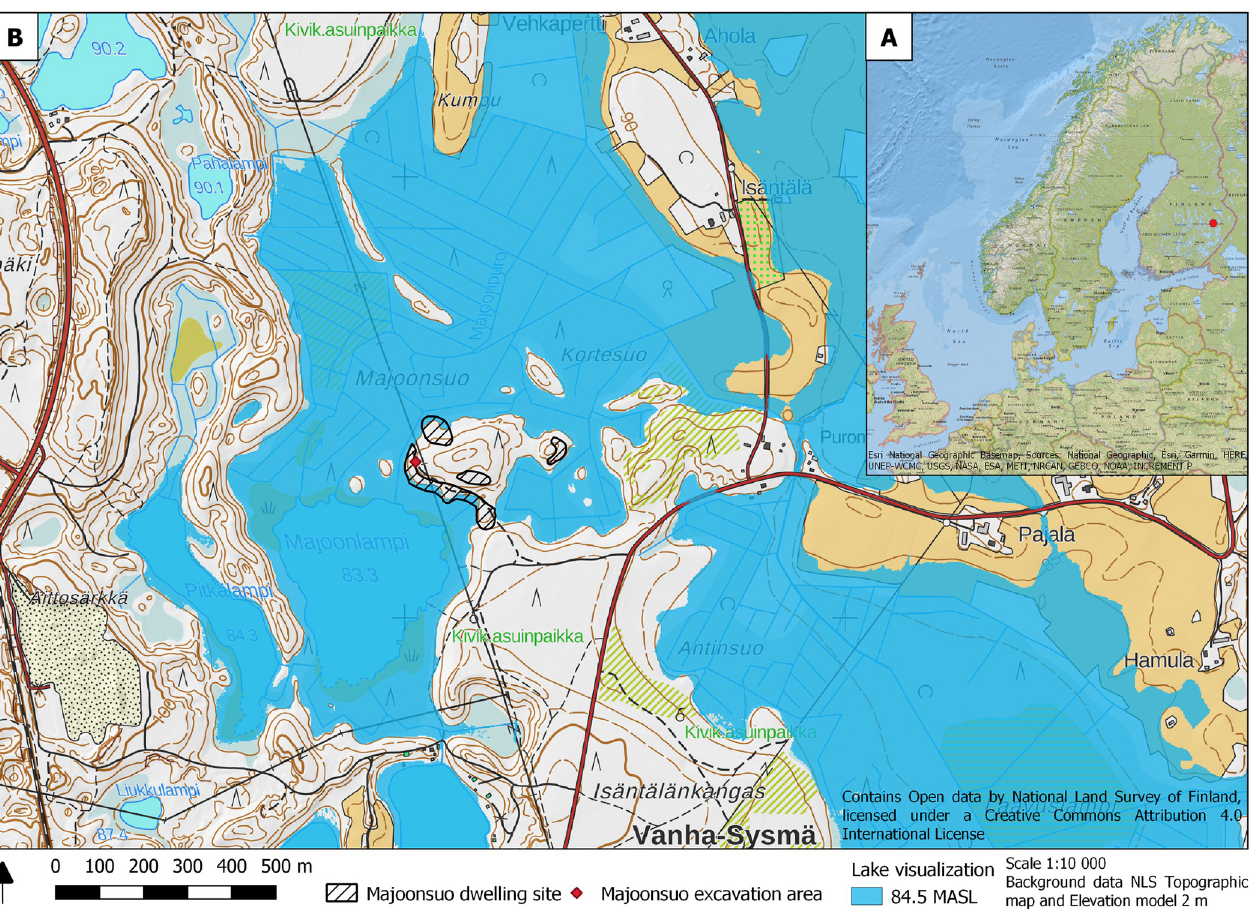
Fig 1. A) The location of Majoonsuo in Finland. Background map: ESRI National Geographic Basemap, sources National Geographic, ESRI, Garmin, HERE, UNEP-WCMC, USGS, NASA, ESA, METI, NRCAN, GEBCO, NOAA, INCREMENT P. CCBY 4.0 International License. B) Majoonsuo dwelling site and excavation area. The Mesolithic water level visualization is 84.5 meters above sea level (MASL). The site has been located on a sheltered lakeshore on a small peninsula. Background map: National Land Survey of Finland, CCBY 4.0 International License. The geographical information of archaeological sites is